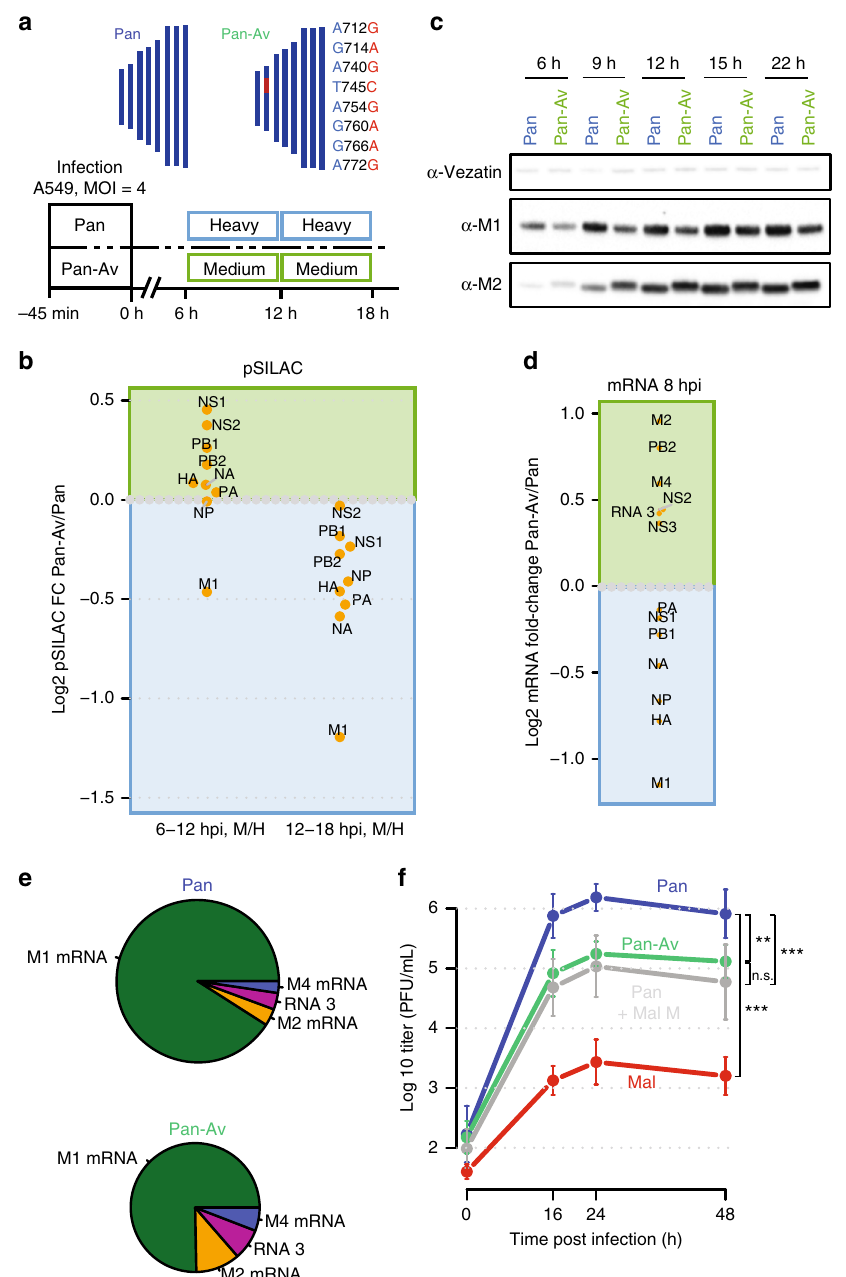
Fig. 6 The 3 ′ splice site is a host range determinant. a (Top) Eight nucleotide polymorphisms of Mal virus at the M segment 3 ′ splice site were integrated into wild-type Pan virus generating “ Pan-Av ” mutant. a (Bottom) Design of pulsed SILAC experiment. A549 cells were infected with wild-type or mutant virus at an MOI of 4 (FFU/cell) and viral gene expression was assessed by pulse labeling during two time intervals. b pSILAC-based quanti fi cation of viral protein production comparatively for Pan and Pan-Av virus. One replicate ( n = 1) is depicted. c Kinetics of M1/M2 protein levels as detected by immunoblotting. d RNA-seq-based quanti fi cation of viral mRNA levels at 8 hpi (MOI = 1 FFU/cell) comparing Pan and Pan-AV infection. The average of n = 2 biological replicates is depicted. e Quanti fi cation of M segment-derived RNAs based on splice junction reads. The area of the pies scales with the total number of splice junction reads. The average of n = 2 biological replicates is depicted. f Multicycle replication curve of the indicated viruses at an MOI of 0.05 FFU/cell on A549 cells. Means and standard deviations of biological triplicates ( n = 3) are shown along with signi fi cance estimates based on two- sided paired t tests for the 16 – 48 h time points (n.s.: non-signi fi cant, ** p < 0.01, *** p <